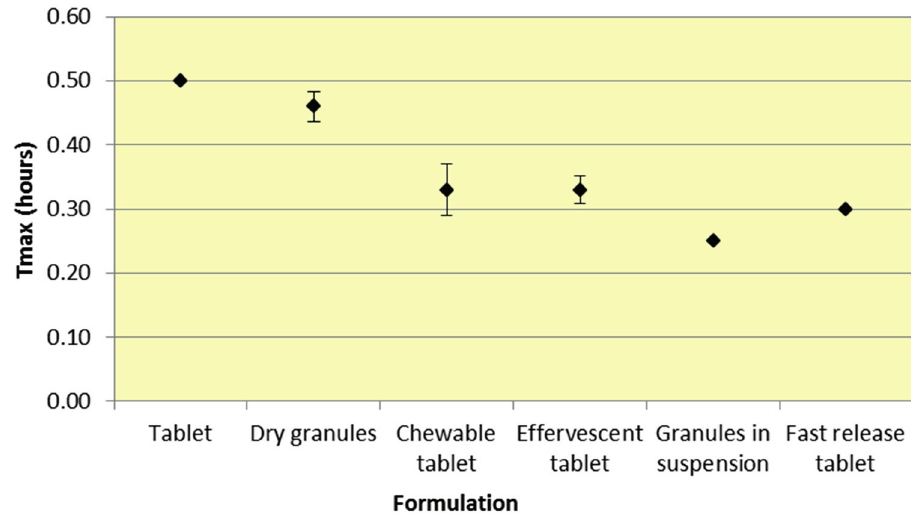
Figure 5. Summary ASA T max for various 500 mg formulations (Median ± SD).